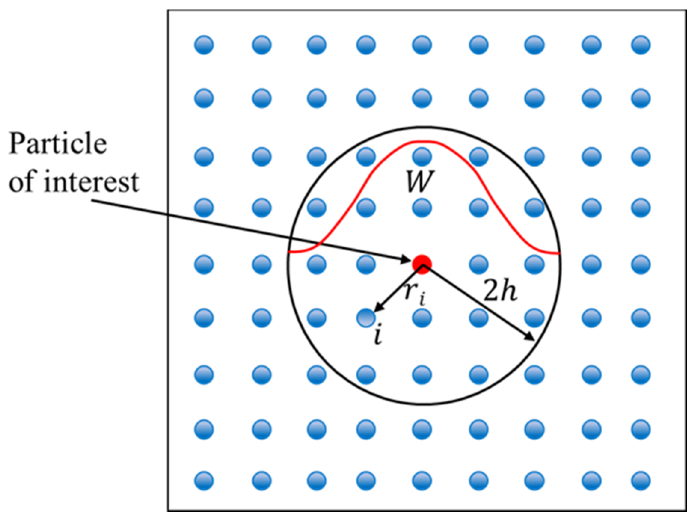
Figure 2. An illustration of the basic principle of the smoothed particle hydrodynamics methodology.